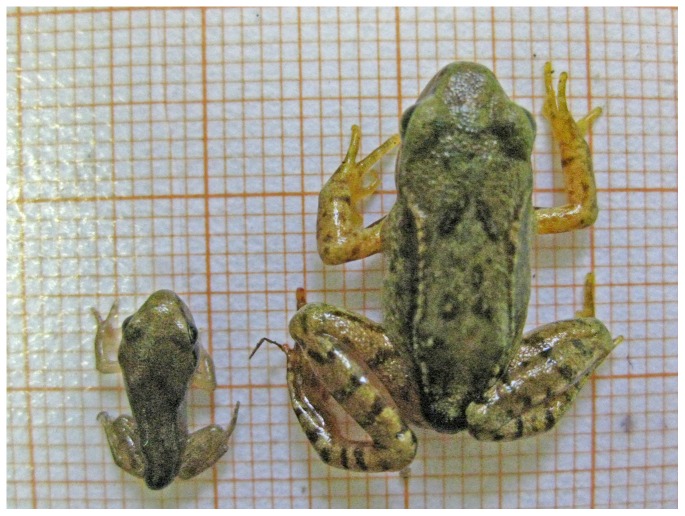

Rana temporaria metamorphs from two different ponds in the study area.Although being in the same developmental stage and emigrating at the same date, the differences in size, proportion and vitality are obvious. Individual left: 10.2 mm, 0.09 g, right: 17.2 mm, 0.56 g, 23 July 2009.